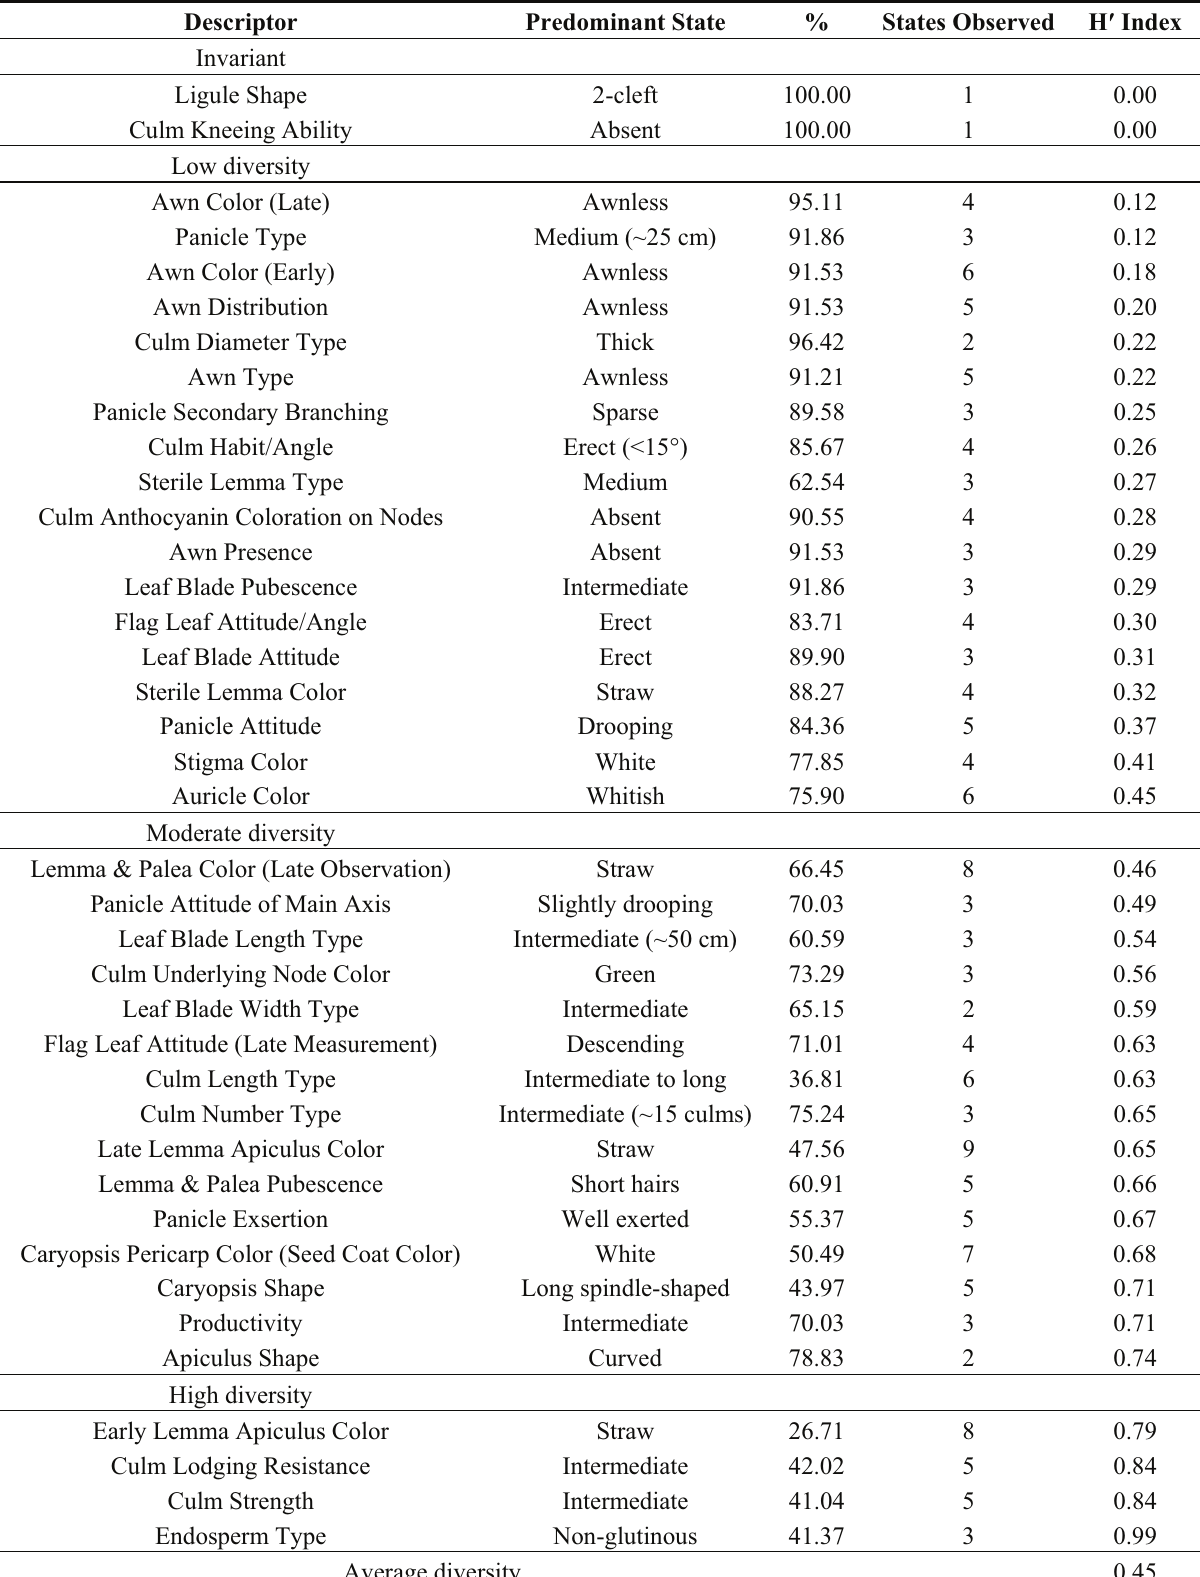
Table 1. Qualitative traits showing the predominant state observed, distribution (%) and the calculated Shannon diversity indices (H (cid:2) ) for each descriptor